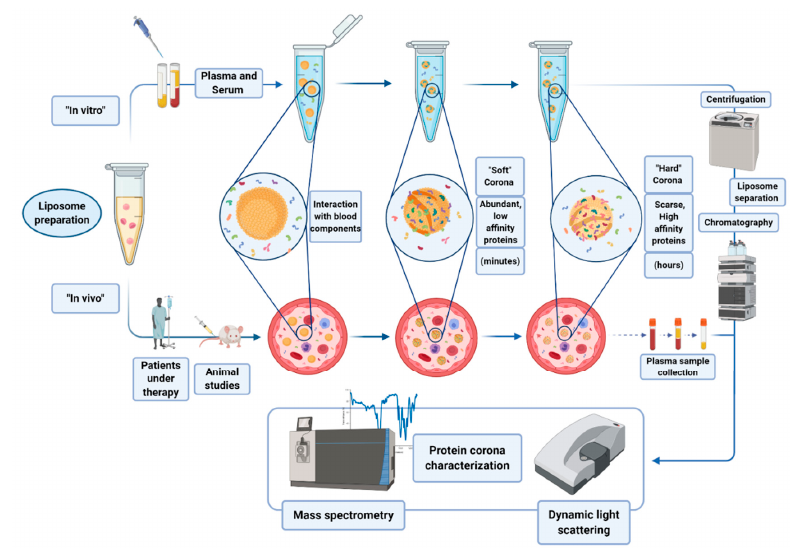
Figure 5. Protein corona formation and analysis.